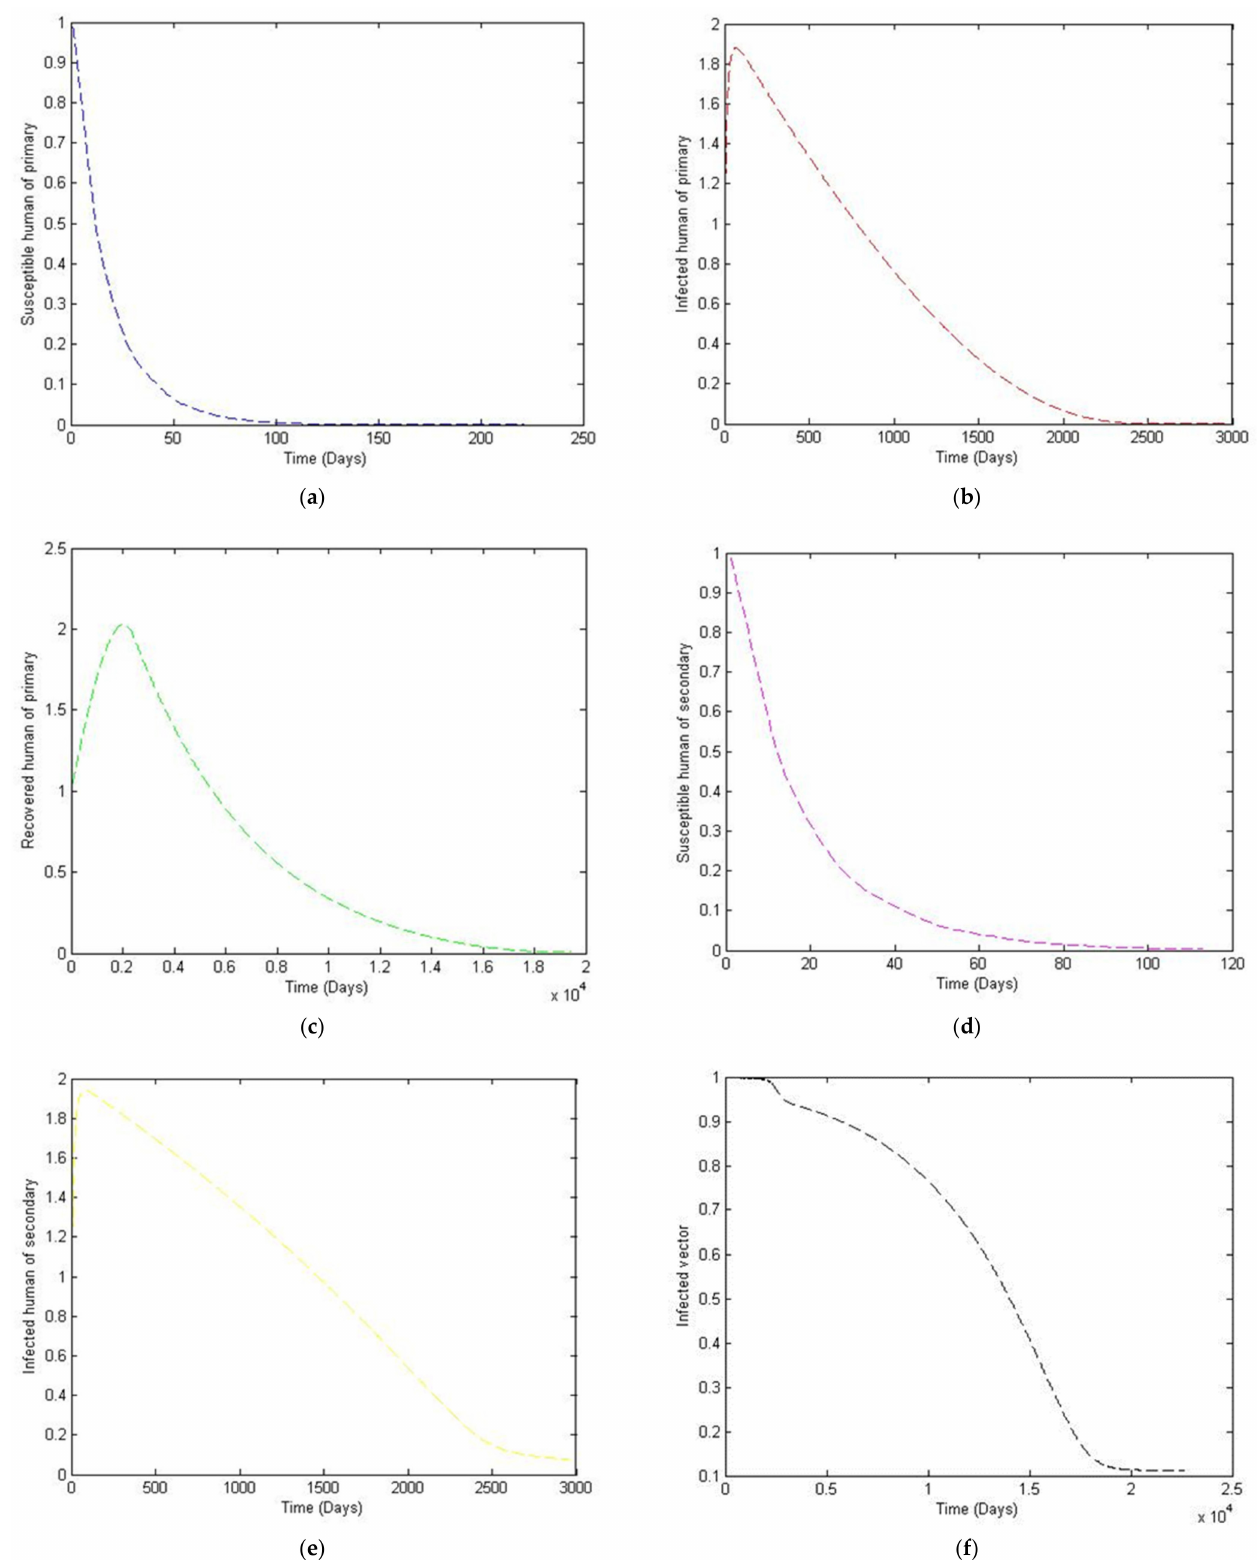
Figure 4. The trajectory of S HP , I HP , R HP , S HS , I HS and I V toward the endemic equilibrium point, for R 0 > 1 with parameter values according to Table 3. ( a ) Susceptibles of primary infection ( b ) Infected population with primary infection ( c ) Recovered human of primary infection ( d ) Susceptibles of secondary infection ( e ) Infected human of secondary infection ( f ) Infected